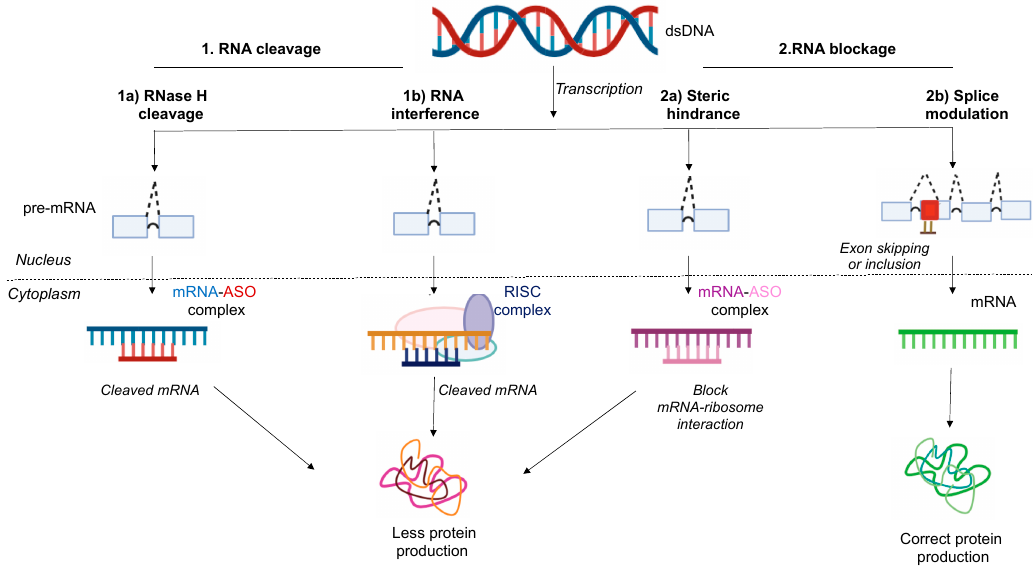
Figure 2. Mechanism of action of antisense oligonucleotides (ASOs): ASOs act by either causing ( 1 ) RNA cleavage or (2) RNA blockage. ( 1a ) RNase H1 mediated cleavage, ( 1b ) RNA interference (RNAi), ( 2a ) Steric hindrance, and ( 2b ) Splice modulation. ( 1a ) ASO-mRNA heteroduplex recruits RNase H1 enzyme and this enzyme cleaves the target mRNA. ( 1b ) mRNA degradation by siRNA associated with RNA inducing silencing complex (RISC). ( 2a ) ASO-mRNA complex sterically blocks and prevents the interaction of mRNA with ribosomes for protein translation. ( 2b ) is an example of splice switching oligonucleotides (SSO). Rectangles depict the coding exon regions separated by a curve depicting the non-coding intron region of the pre-mRNA. The red square represents the mutated region of the exon. The dashed line represents the splicing pattern of pre-mRNA. RNase H1 mediated cleavage, RNA interference, and steric hindrance mechanisms produce less protein, while splice modulation produce the correct form of protein. Phosphorothioate (PS) and 5 ′ methylcytosine base modification induces mRNA cleavage. Peptide nucleic acids (PNA), 2 ′ -O-methyl (2 ′ -O-Me) and 2 ′ -O-methoxyethyl (2 ′ -O-MOE) modifications, phosphorodiamidate morpholino (PMO), locked nucleic acid (LNA) act on mRNA to sterically block its translation or these ASOs can act as SSO to modulate splicing pattern.